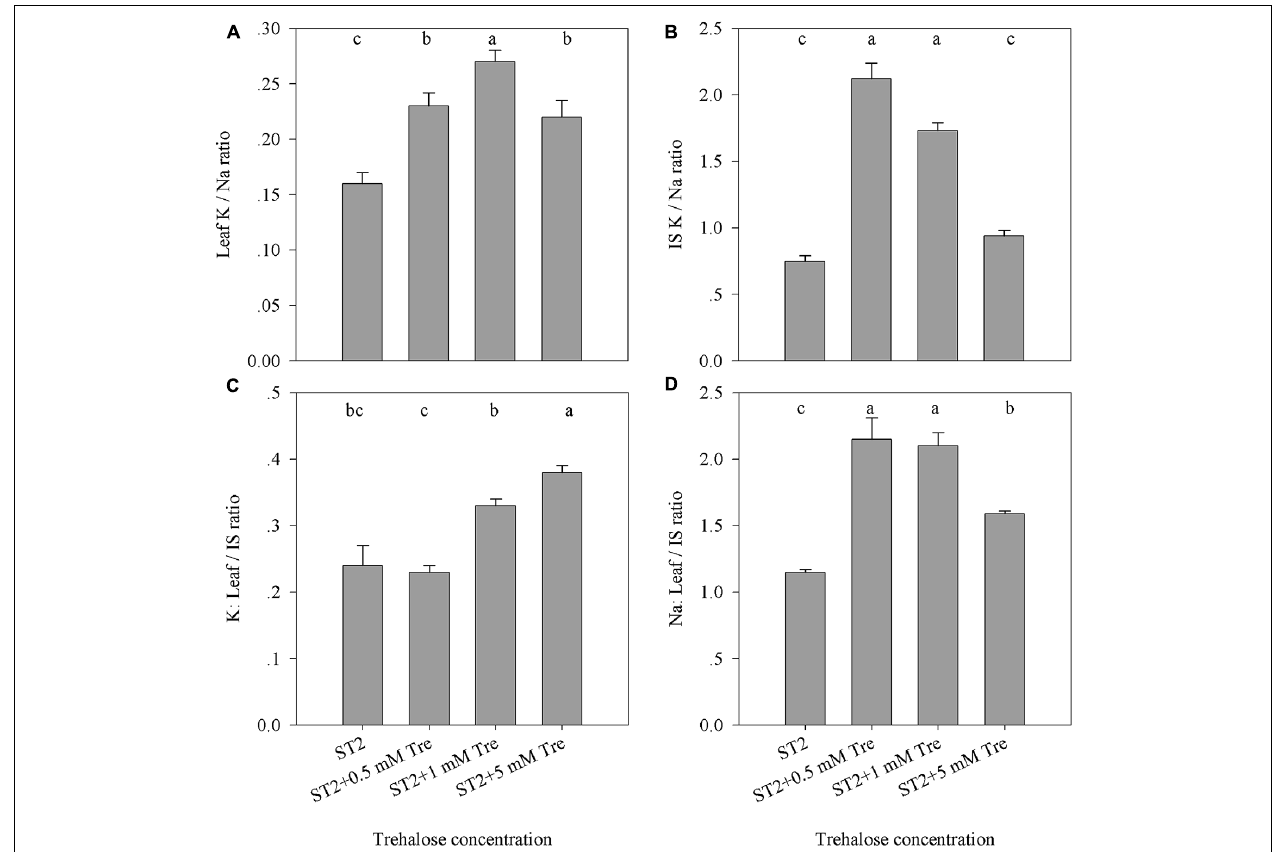
FIGURE 3 |The effects of exogenous Tre on the ratio of Na and K accumulated in the leaf or IS of plants under ST2 condition. (A) Leaf K/Na ratio; (B) IS K/Na ratio; (C) The ratio of K in leaves compared to IS; (D) The ratio of Na in leaves compared to